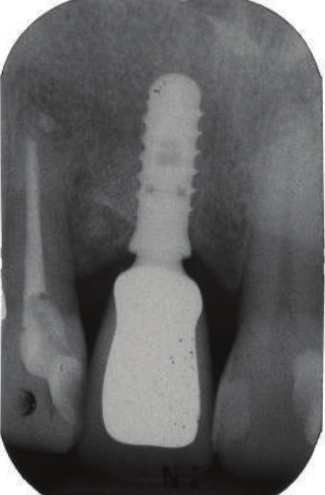
Figure 23: Periapical radiograph taken two years after implant